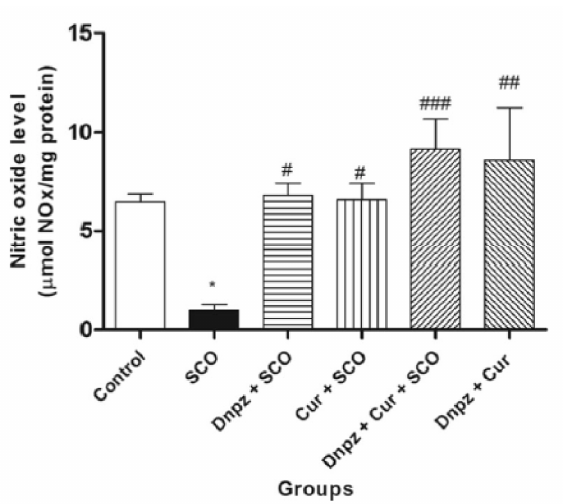
Figure 3. Effect of combination of 50 mg/kg curcumin and 2.5 mg/kg donezepil (Nnzp) after application of scopolamine (SCO) on NO levels. (* p < 0.05 vs control; # p < 0.05, ## p < 0.01, ### p < 0.001 vs SCO) [5]. Reproduced from [5] with the permission from